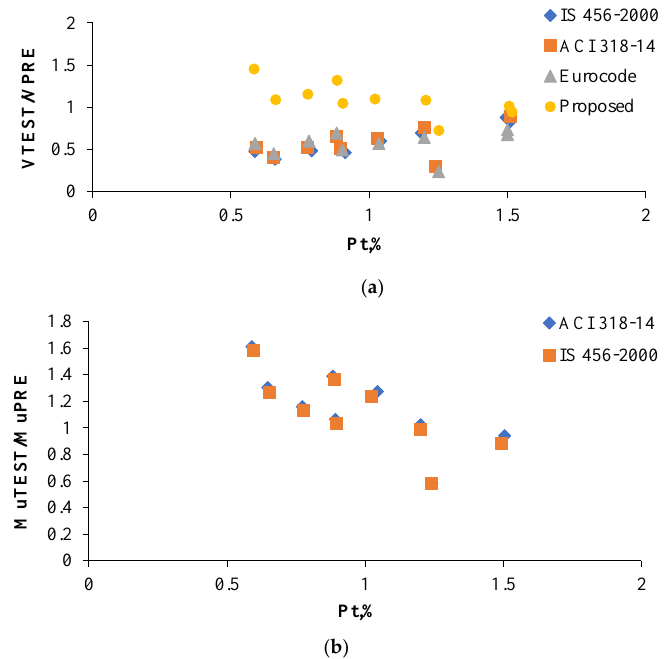
Figure 9. Mechanical strength ratio vs. percentage of tension reinforcement ( a ) effect of reinforcement ratio; ( b ) effect of wire mesh.